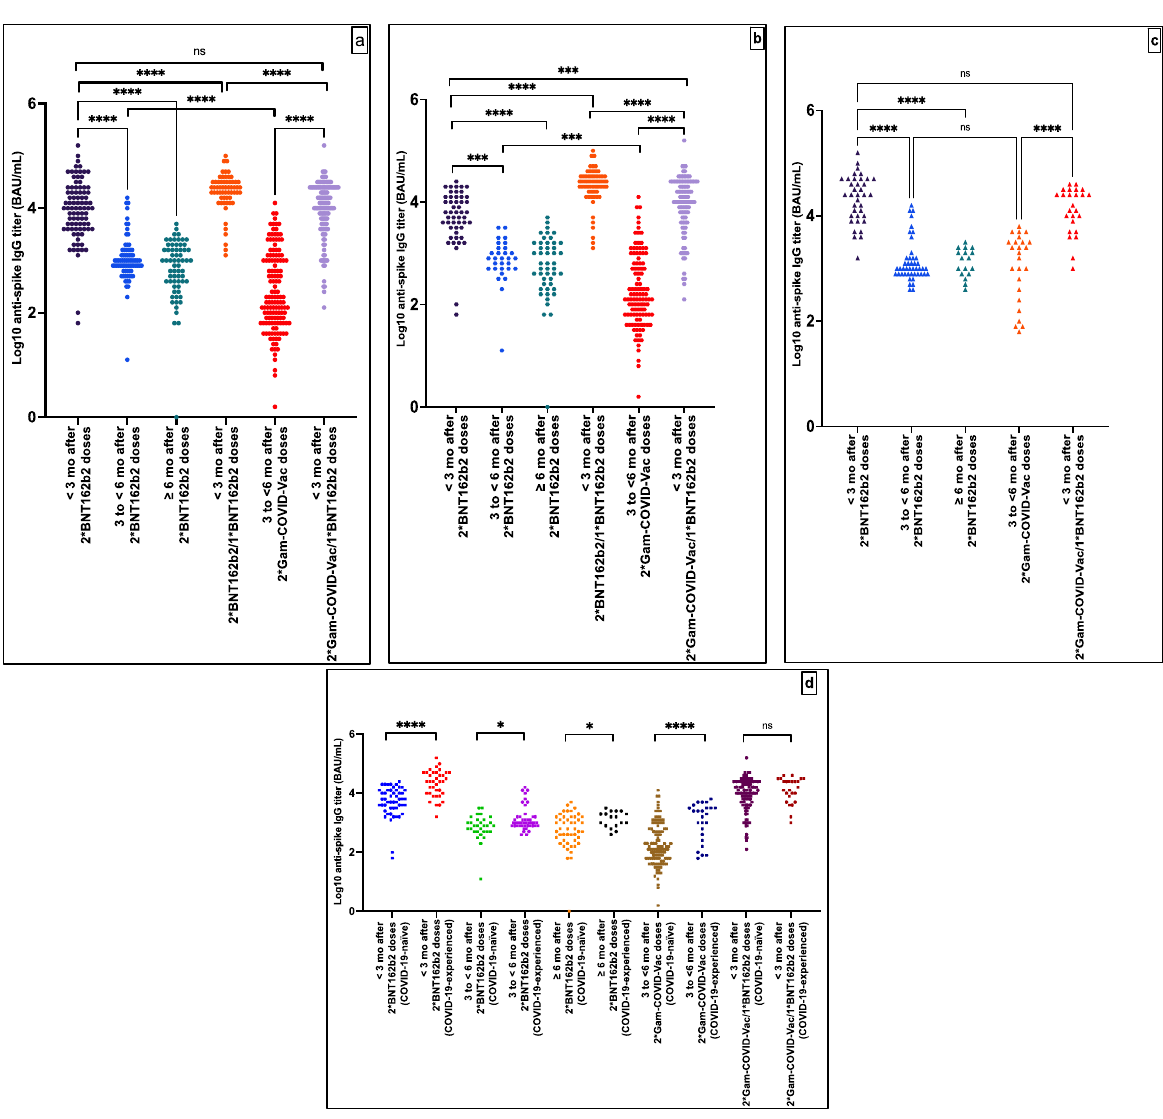
Figure 3. Immune responses against the SARS-CoV-2 spike protein after different vaccination schemes at different time points in subgroup analyses among all participants ( a ), COVID-19-naïve ( b ), COVID-19-experienced ( c ), COVID-19-naïve versus COVID-19-experienced ( d ). N.B.: Results of anti-S-IgG titers are log transformed. Initial measurement results were in U/mL, with the cut-off point defined as 0.80 U/mL to differentiate samples as reactive (≥0.80 U/mL) and non-reactive (<0.80 U/mL) for anti-S-IgG. In all the groups, participants were humorally reactive. ns: (not significant) means p > 0.05, * means p ≤ 0.05, *** means p ≤ 0.001, **** means p ≤ 0.0001